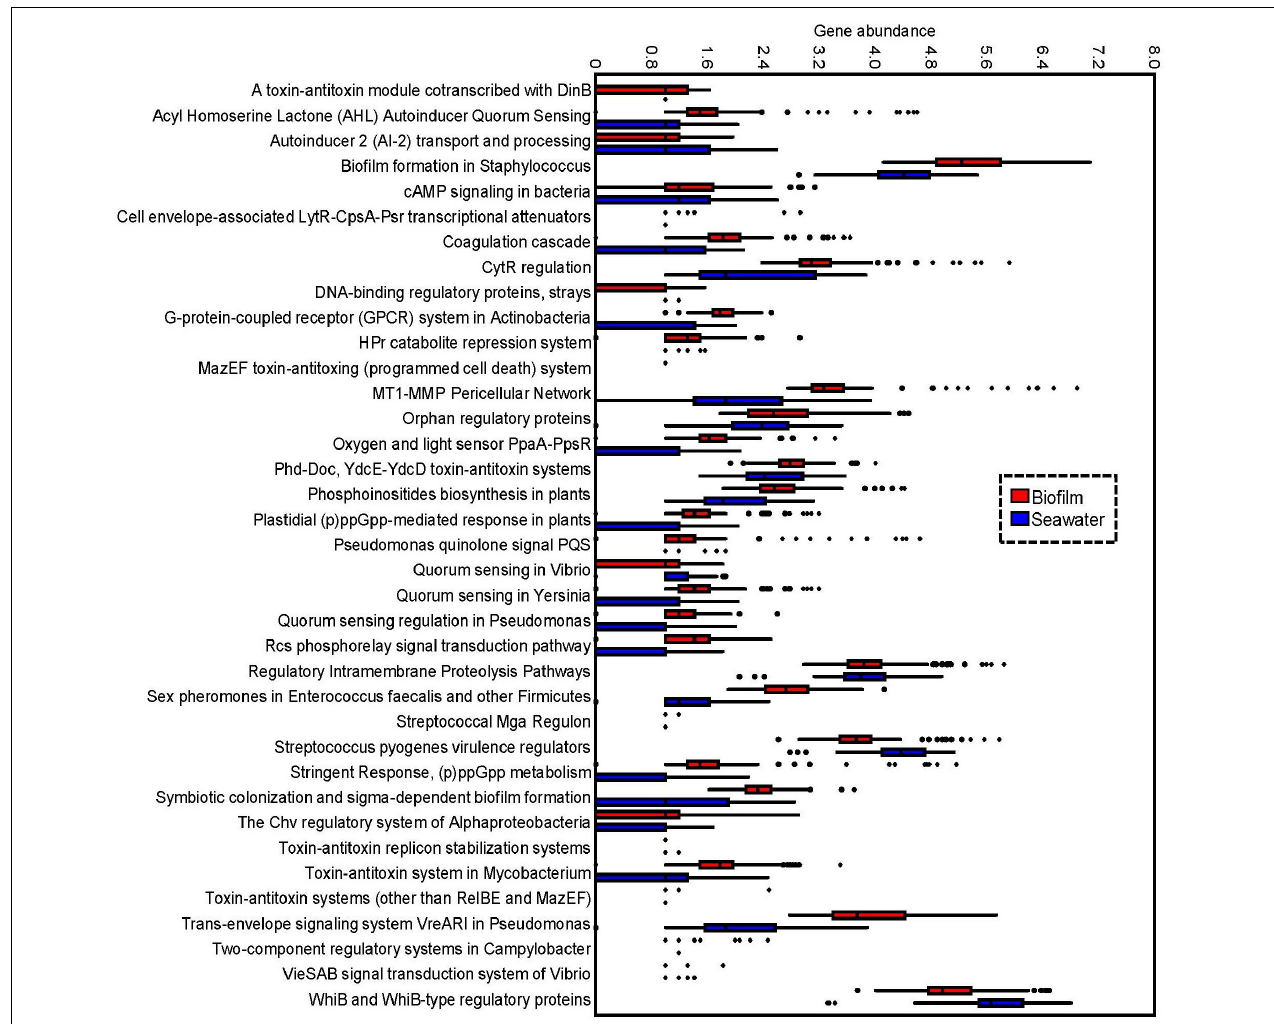
FIGURE 3 | Difference of regulation and signal transduction subsystems between the biofilm and seawater microbial communities. The abundance (based on fourth root) of different subsystems under the category. Regulation and signal transduction in 101 biofilms and 91 seawater metagenomes were compared, and the 37 significantly different (two-tailed Student’s t -test, p < 0.01) subsystems are shown. All the metagenomes were normalized to equal data size (i.e., 10,000,000 reads per metagenome), and the abundance of a subsystem was indicated by the number of metagenomic reads mapped to the gene belonging to this